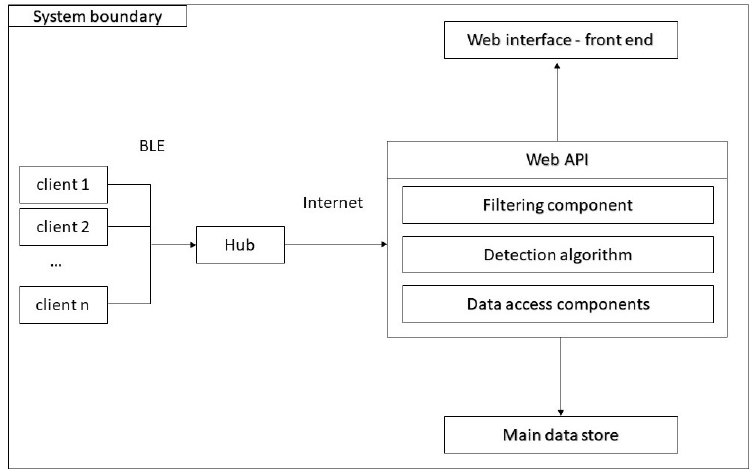
Figure 1. Final architecture of the